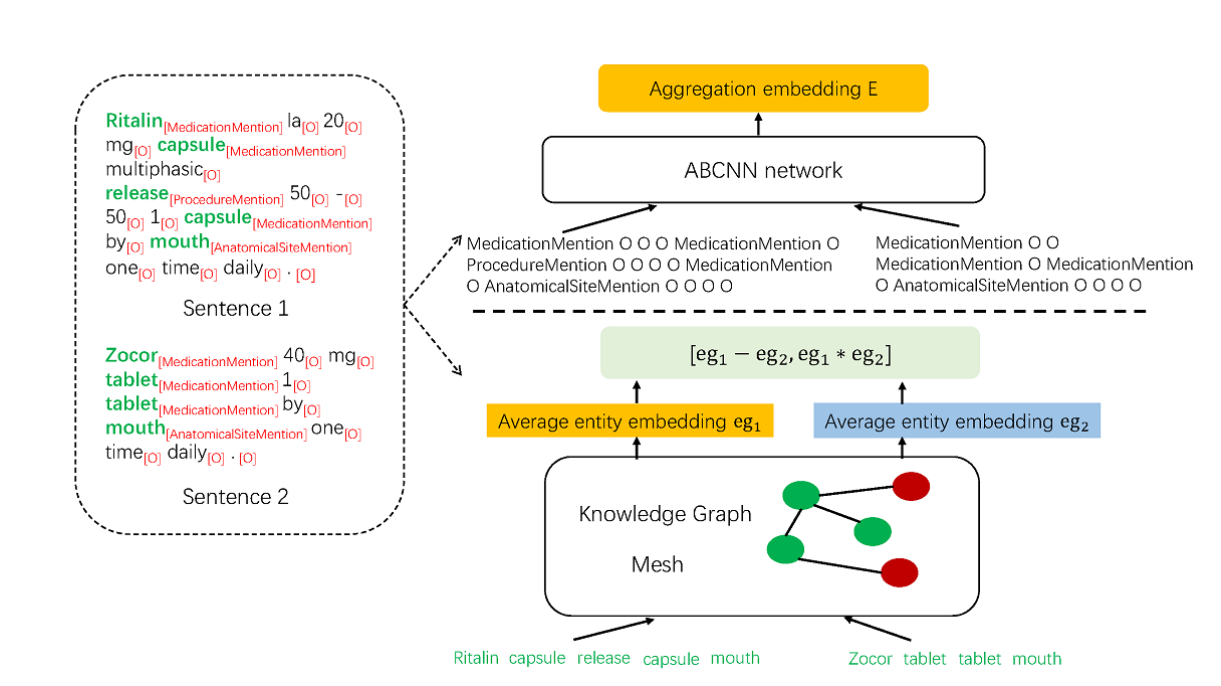
Figure 2. Entity-level